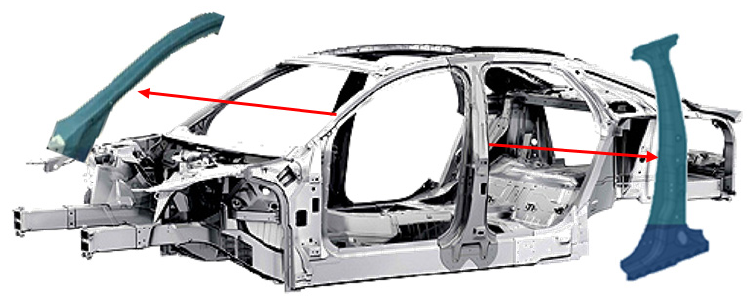
Figure 6. Basic vehicle body construction showing the “A” and “B” pillars [40].